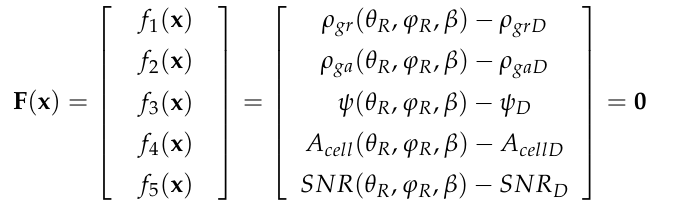
Figure 15. SNR with respect to and under HH polarization.